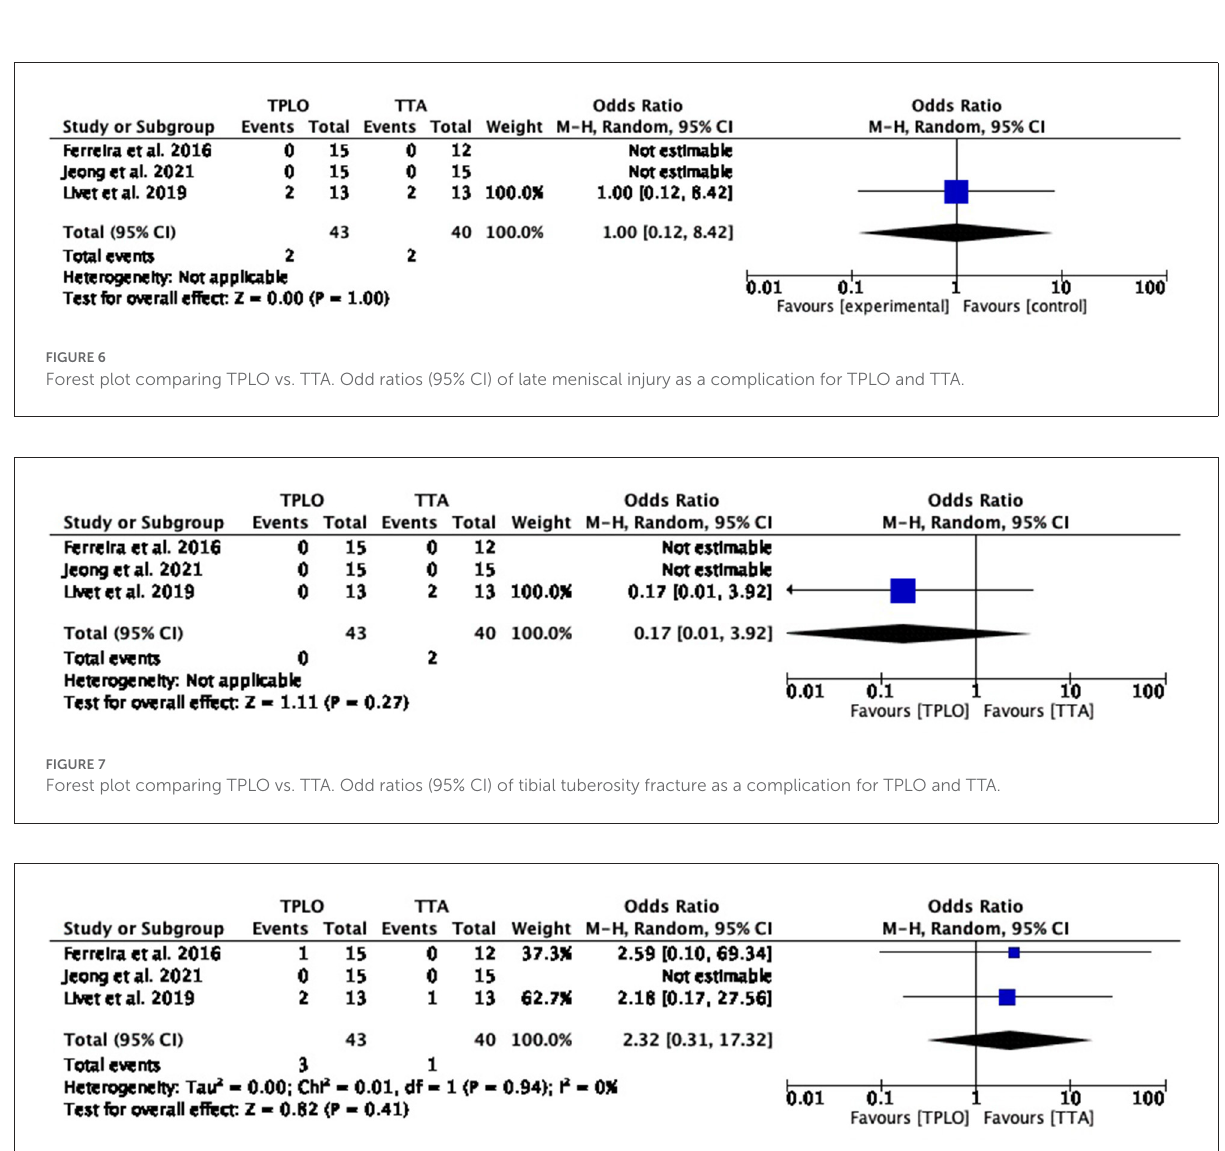
FIGURE8 Forest plot comparing TPLO vs. TTA. Odd ratios (95% CI) of fibular fracture as a complication for TPLO and